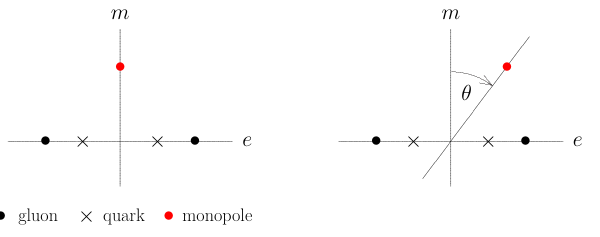
Figure 2. The color-electric – color-magnetic charge lattice for vacuum angle θ “ 0 and θ ą 0, with regard to the gauge group U(1). Gluons have color-electric charge ˘ 1, quarks have charge ˘ 1 { 2, and monopoles have color-magnetic charge ˘ 1 in Dirac